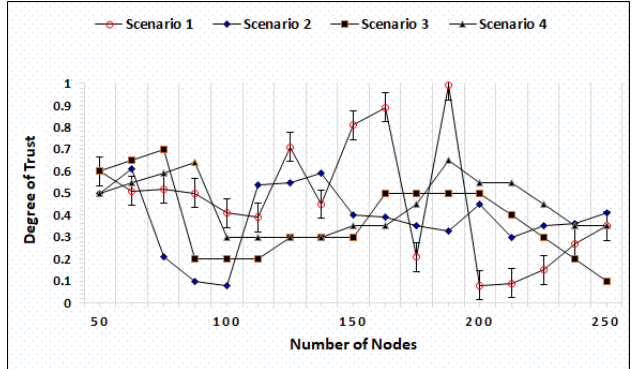
Figure 12. White washing attack with distinct scenario.